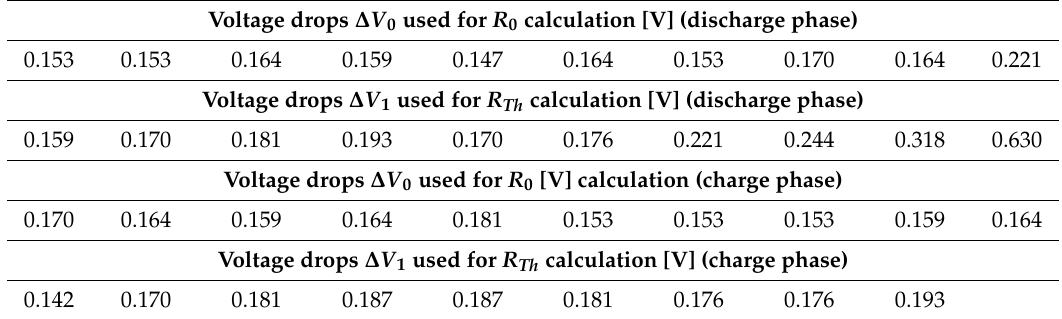
Table 3. Charge / discharge test results. Table 3. Charge/discharge test results.